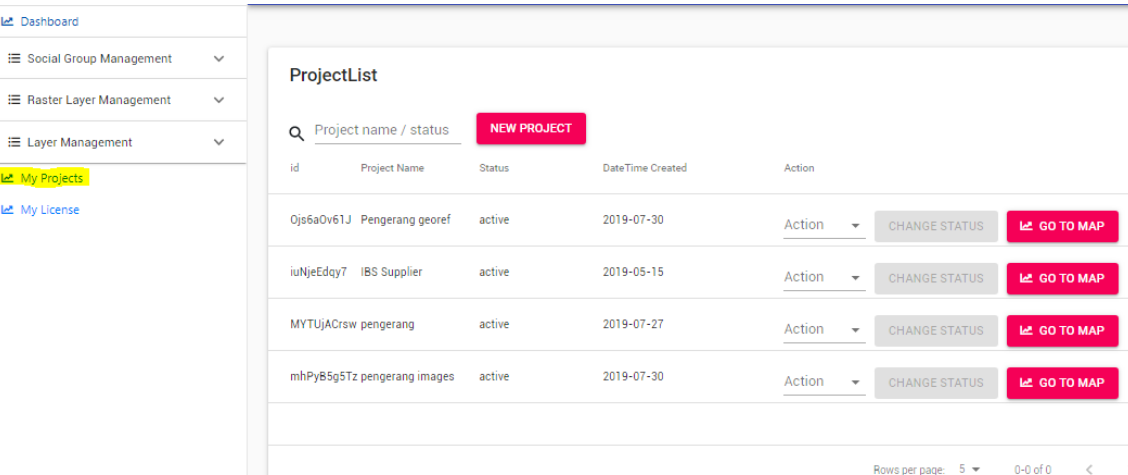
Figure 19: Proposed GIS integrated solution provides Project Management as for local authority and stakeholders to manage different location or development application from